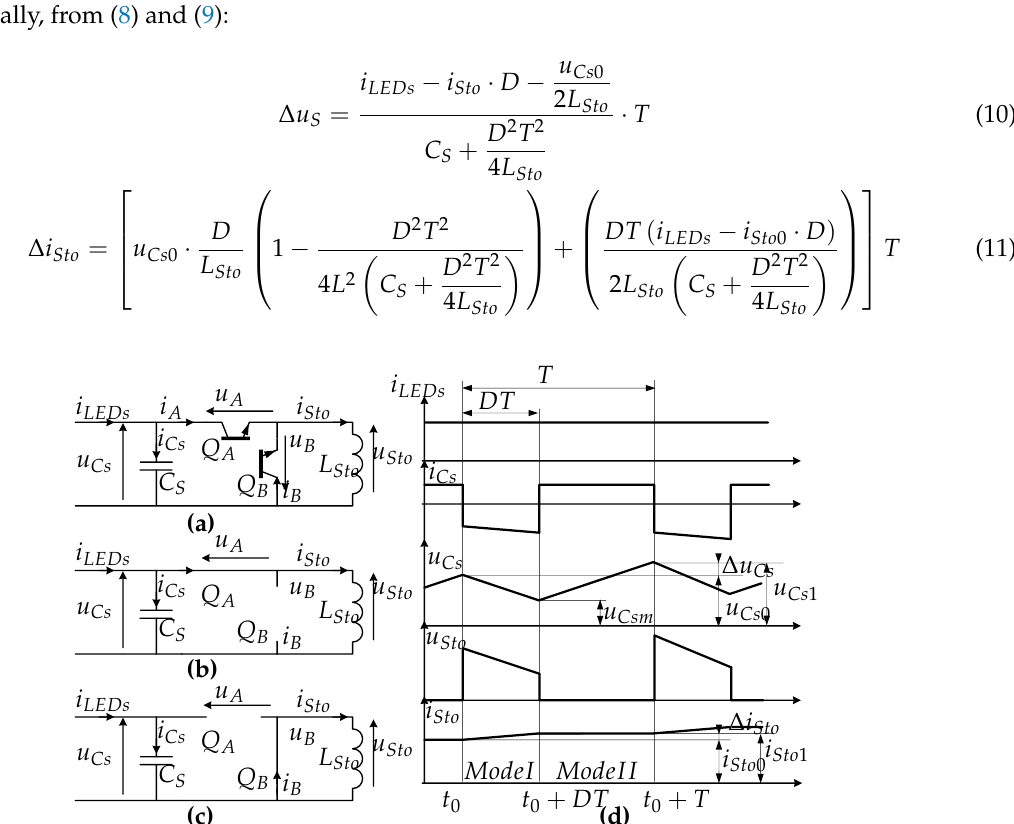
Figure 4. Switching modes of the proposed second stage. ( a ) Voltage and current references of the circuit. ( b ) Mode I, Q A switched on, Q B switched off. ( c ) Mode II, Q A switched off, Q B switched on. ( d ) Main theoretical waveforms of the output stage.